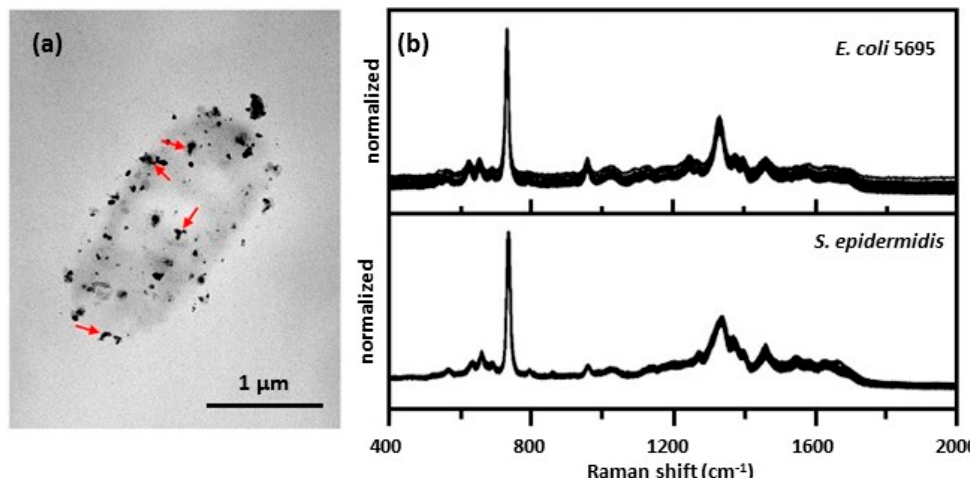
Figure 6. ( a ) TEM image of E. coli 1116 showing the colloid deposits that formed on the cell wall (bacteria(H 2 O)@AgNP) [38]. Red arrows indicate Ag composites that have large, elongated structures. ( b ) SERS spectra obtained for E. coli 5695 and S. epidermidis in contact with clusters of Ag NPs [38]. Spectra were obtained for 15 different batches of samples using 633 nm excitation. Reproduced with permission from the American Chemical Society.